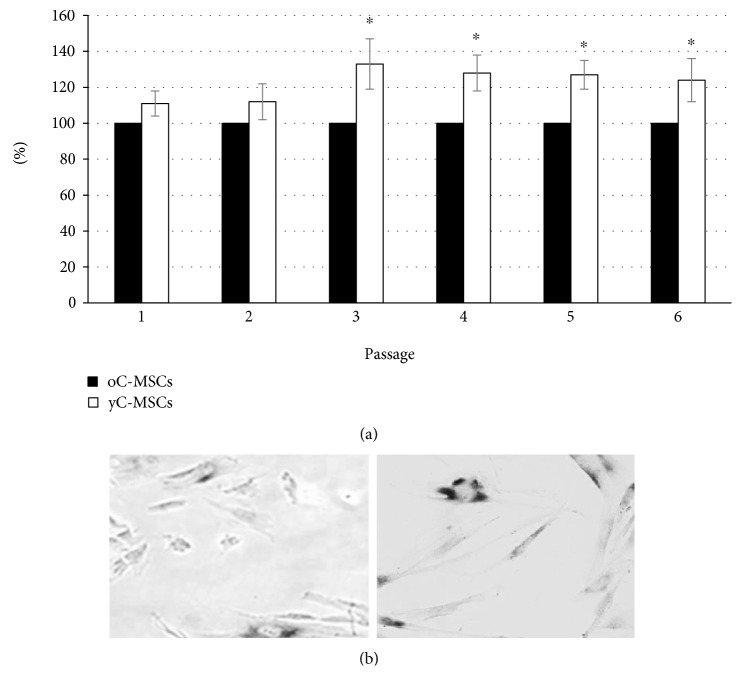
XTT assay and senescence-associated beta-galactosidase assays of MSCs derived from younger (yC-MSCs) and older (oC-MSCs) cervixes. (a) XTT assay performed after 72 hours of culture for the first 6 passages. Data from oC-MSCs are expressed as 100%, and those for yC-MSCs are calculated accordingly. Data are reported as mean ± SD of three independent experiments. ∗p < 0.05 for yC-MSCs versus oC-MSCs. (b) Representative micrographs obtained with phase-contrast microscopy showing SA-β-Gal activity in cells at passage 6.